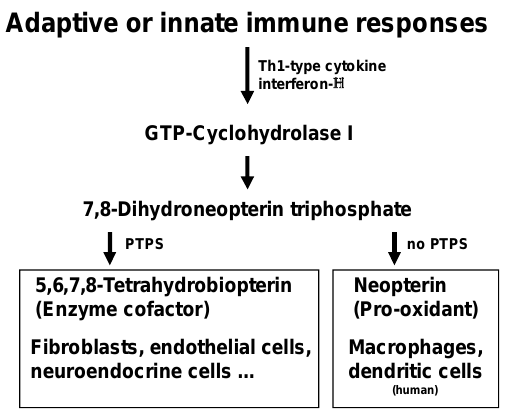
Figure 2. Formation of pteridines 5,6,7,8-tetrahydro- biopterin (BH ) and neopterin during the Th1-type 4 immune response: Th1-type cytokine interferon- induces GTP-cyclohydrolase I, the key enzyme for the biosynthesis of pteridines in various cells and species, which leads to an accumulation of the intermediate 7,8-dihydroneopterin triphosphate. In various cells like fibroblasts, hepatocytes, endothelial cells and neu- roendocrine cells from various species pyruvoyl- tetrahydropterin synthase (PTPS) rapidly converts 7,8- . dihydroneopterin to form the enzyme cofactor BH 4 Fig. 3 Inflammation and immune activation impair the Human monocytes/macrophages and dendritic cells activity of phenylalanine 4-hydroxylase (PAH). Th1- lack activity of PTPS and thus neopterin derivatives type cytokine interferon- g induces formation of . accumulate at the expense of BH 4 5,6,7,8-tetrahydrobiopterin (BH ) and in parallel high 4 output of reactive oxygen species (ROS), which wipe out antioxidant pools including BH and oxidative 4 stress develops. BH -dependent enzymes begin to suf- 4 fer as activity of the liver enzyme phenylalanine 4- hydroxylase becomes impaired. As a consequence, phenylalanine concentrations begin to